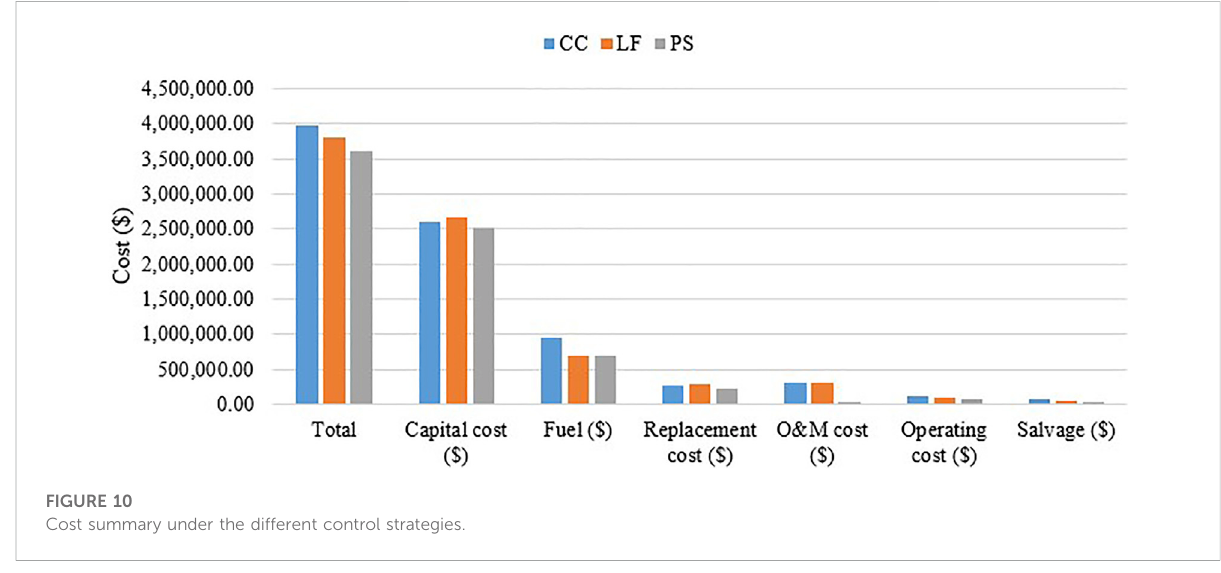
FIGURE 10 Cost summary under the different control strategies.